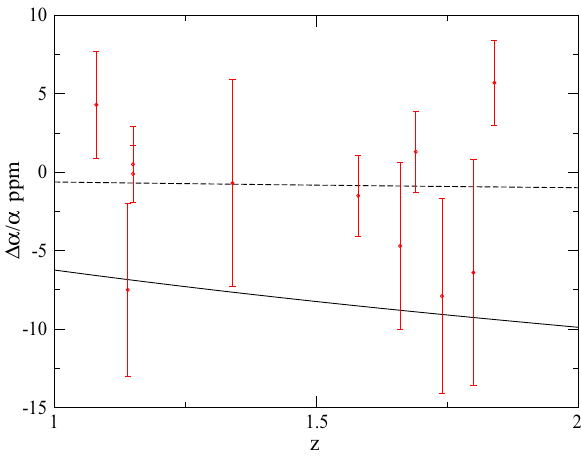
Fig. 8 The data points of Table 1 on the relative variation (cid:7)α em /α em at different redshifts (in ppm). The solid and dashed lines correspond to the theoretical combined RVM-GUT prediction based on Eq. (38) for the values ν B = 10 − 4 and 10 − 5 , respectively. The tendency of the data to reflect smaller values of α em at large z is correctly described by the theoretical curves (which indicate (cid:7)α em < 0), although the current observational errors are still too